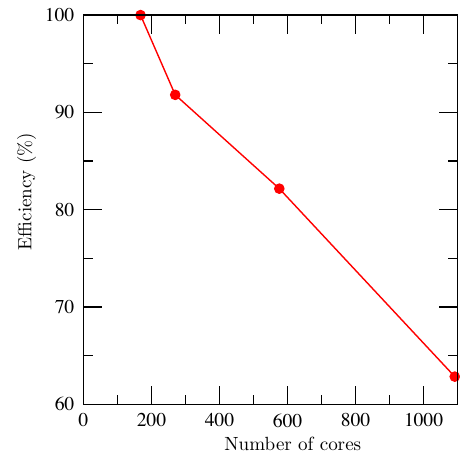
Fig. 4. Efficiency for a weak scalability experiment using the block preconditioner for an approximate number of nodes in all meshes of 4200 and meshes from 0 . 708 × 10 6 nodes up to 4 . 58 × 10 6 nodes.